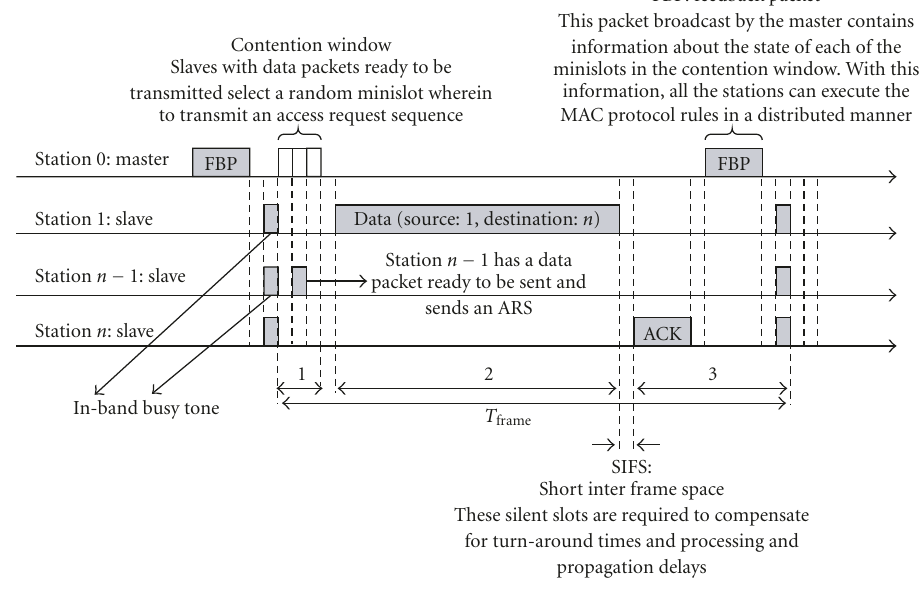
Figure 2: DQMAN Frame